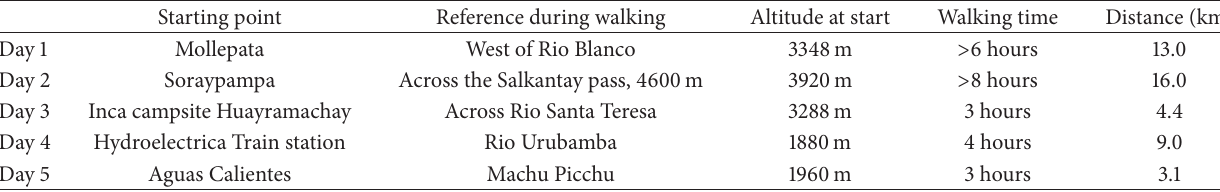
Table 1: Description of the Salkantay expedition.